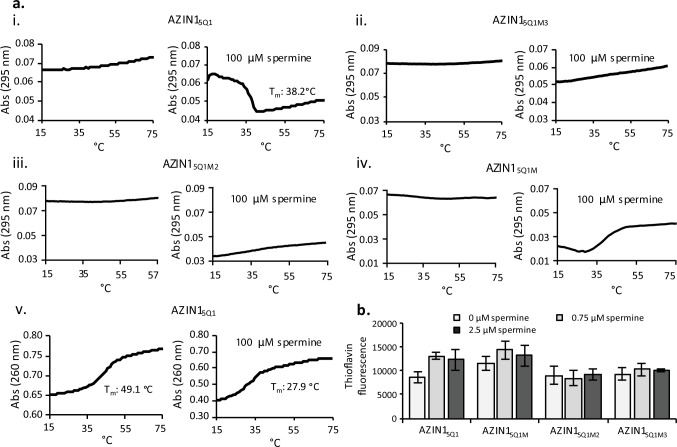
Polyamine-related biophysical analysis of AZIN15Q1.AZIN1 G2 quadruplex is induced by polyamines in vitro (a) Effect of spermine on UV melt profiles of (i) AZIN15Q1 (295 nm), (ii) control AZIN15Q1M3, (iii) control AZIN15Q1M2, (iv) control AZIN15Q1M (295 nm) and (v) AZIN15Q1 (260 nm) in the presence of 1 mM K+. Two replicates of each biophysical experiment were performed. (b) Effect of spermine for 1 hr on Thioflavin T fluorescence of AZIN15Q1, AZIN15Q1M, AZIN15Q1M2 and AZIN15Q1M3 in the presence of 1 mM K+ and 4.5 µM Thioflavin. The error bars represent the standard error (SE) from three independent replicates. AZIN15Q1M2: GGACCCAGACAUAGGCUUGGUAA; AZIN15Q1M3: AAACCCAGACAUAGGCUUGGUGG.